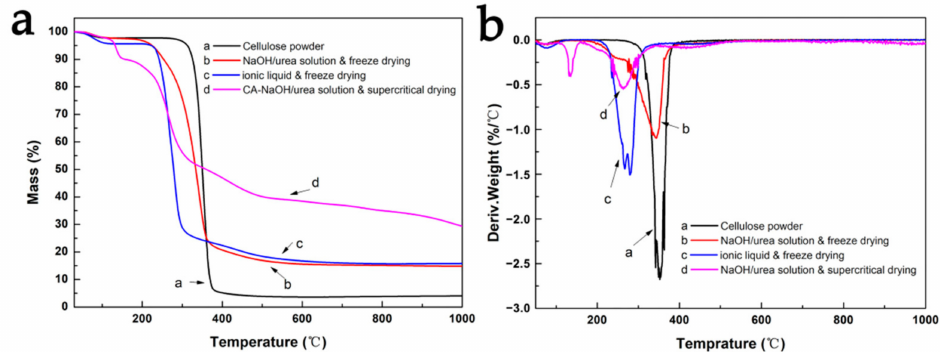
Figure 4. ( a ) TG curve and ( b ) DTG curve of raw cellulose powder and cellulose aerogels prepared under different